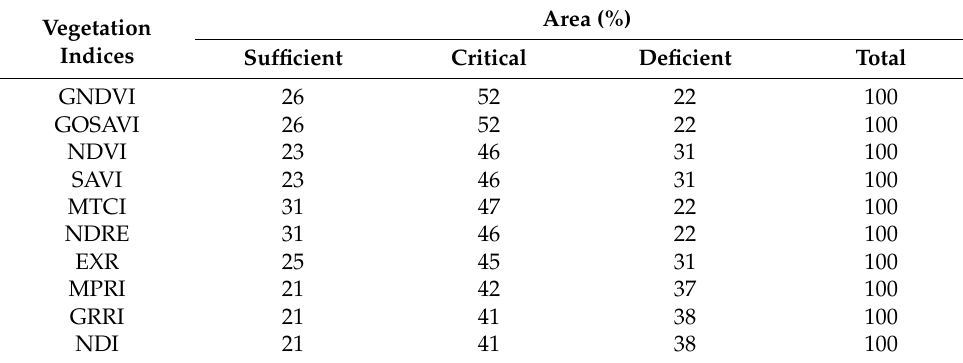
Figure 7. Predictive maps of the N content spatial distribution in coffee leaves, obtained from the classification of images using RF from vegetation indices Excessive Red (EXR), Green–Red Ratio Index (GRRI), Modified Photochemical Reflectance Index (MPRI), and Normalized Different Index (NDI). Table 4. Percentage (%) of areas in the coffee plantation that had N content sufficient, critical, and deficient, according to the appraisal maps of the N content spatial distribution in coffee leaves, presented from the best performance to the worst